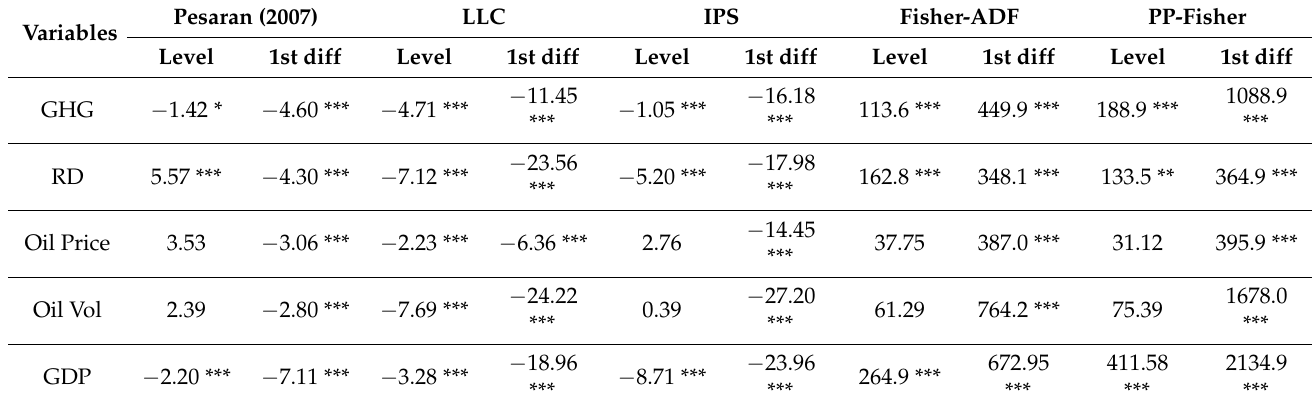
Table A1. Unit root